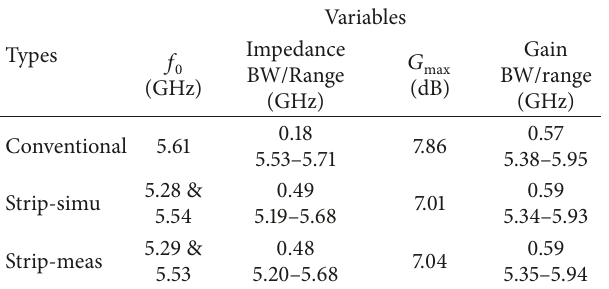
Table 3: Comparisons between the conventional antenna and Antenna